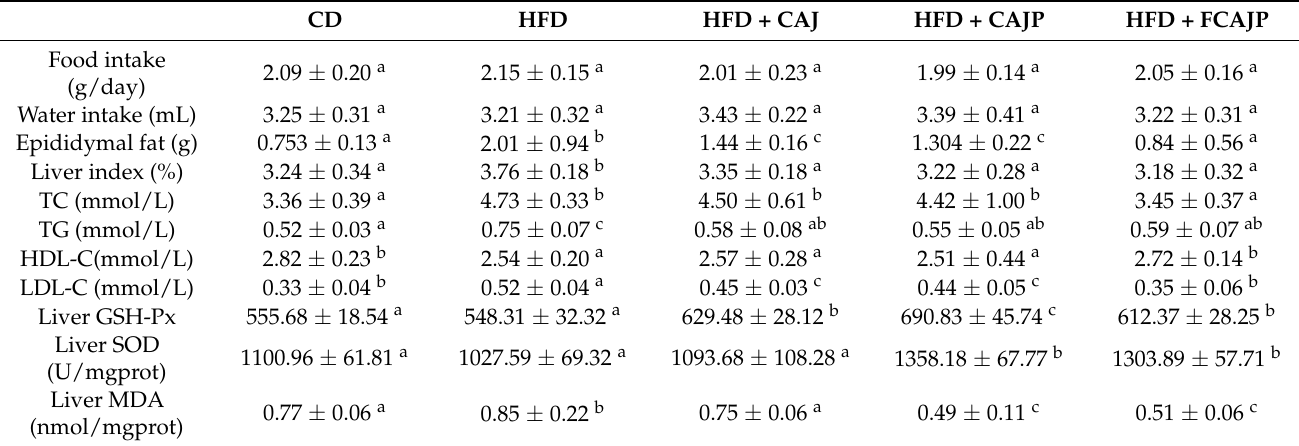
Table 1. Influences of three cloudy apple juices on growth performance, serum and hepatic parameter.